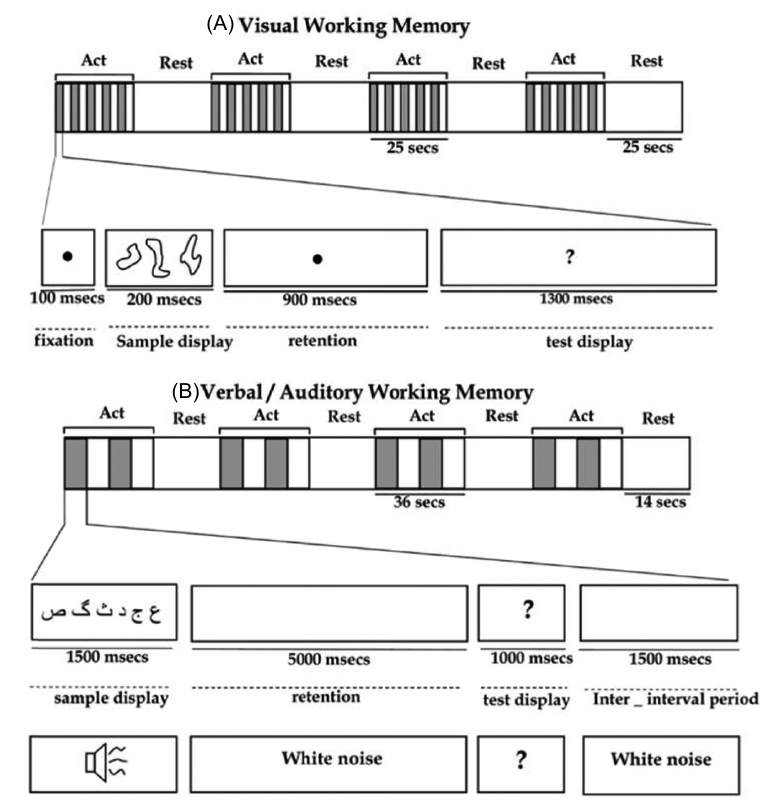
Fig. 1. Illustration of task design. A: visual working memory. B: verbal and auditory working memory tasks. Question marks mean “decision time” for the